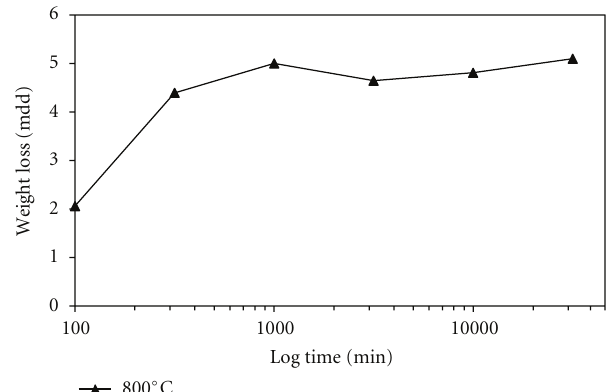
Figure 4: The change in weight loss with ageing time.